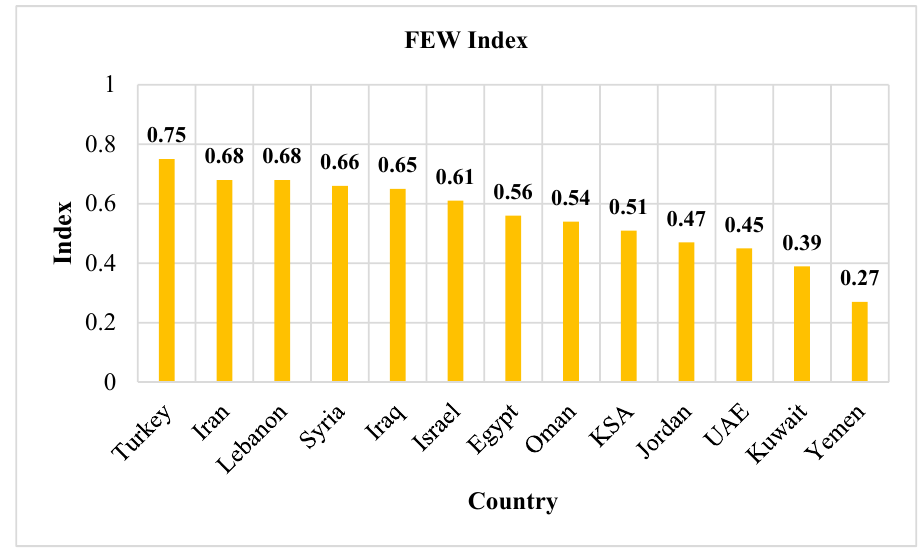
Figure 1. The Pardee RAND Food-Energy-Water security index. Note: the countries not listed in the figure were not reported due to data unavailability. The data is acquired from Willis et al. [33].